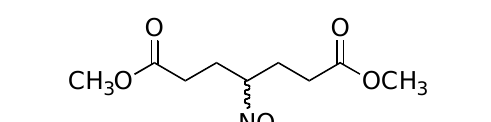
Figure 1. Double 1,4-addition product, compound 6.